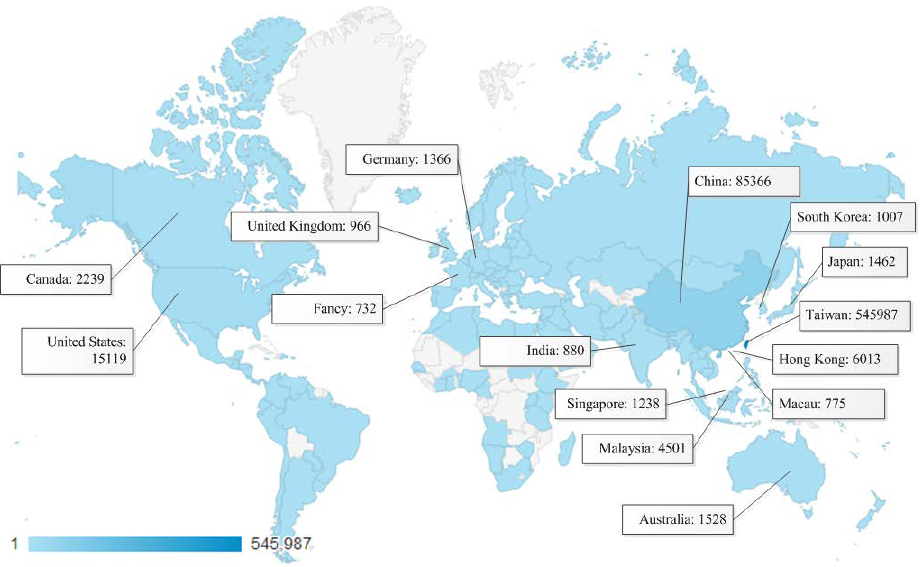
Figure 6. Map overlay on the visits of NTHU OCW around the world.